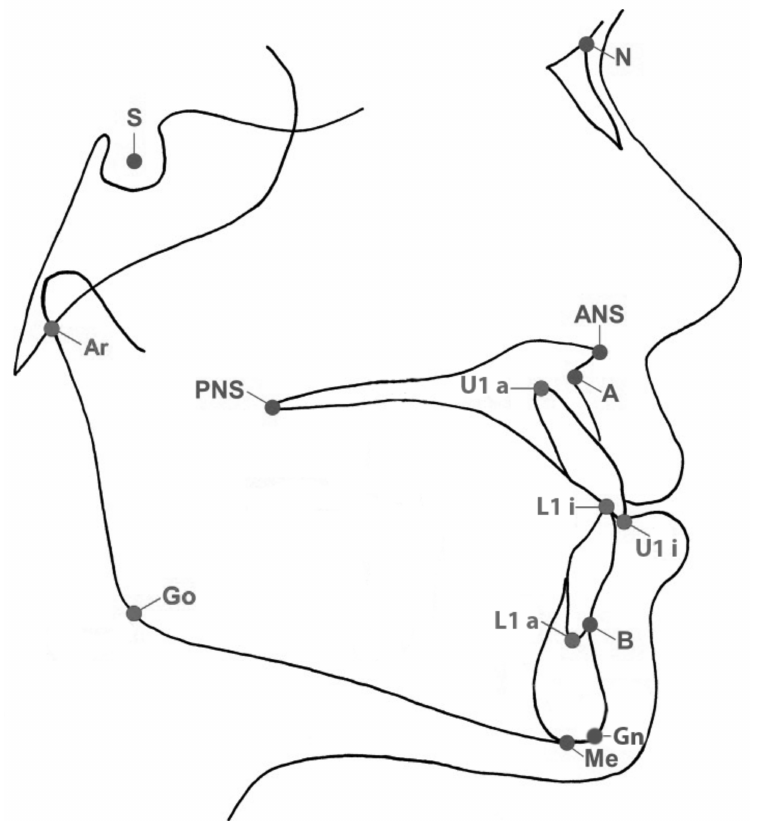
Figure 1. Description of the cephalometric points included in this study. S = Sella; N = nasion; ANS = anterior nasal spine; PNS = posterior nasal spine; A = Point A (most concave point of the anterior maxilla); B = Point B (most concave point of the mandibular symphysis); U1 a = upper incisor root apex; L1 apex = lower incisor root apex; U1 i = incisal edge of the upper incisor; L1 i = incisal edge of the lower incisor; Me = Menton (most inferior point of mandibular symphysis); Gn = gnathion (midpoint between the pogonion point and Me); Ar = (junction between the inferior surface of the cranial base and the posterior border of the ascending rami of the